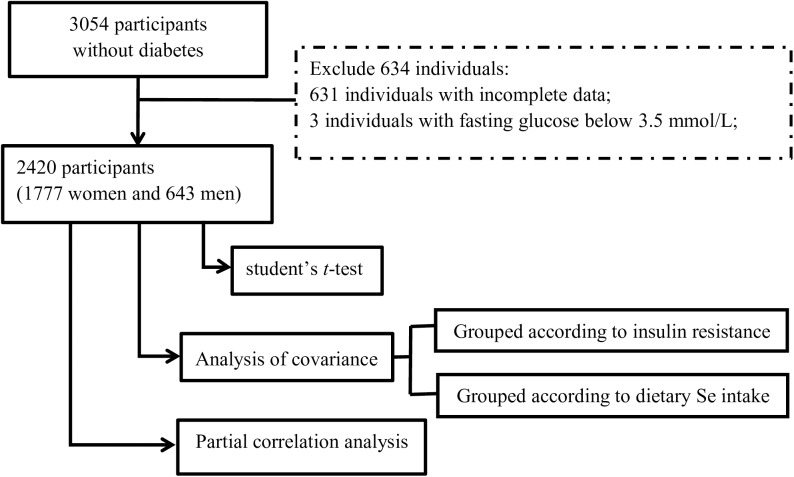
Flow-chart of subjects selection for analyse.